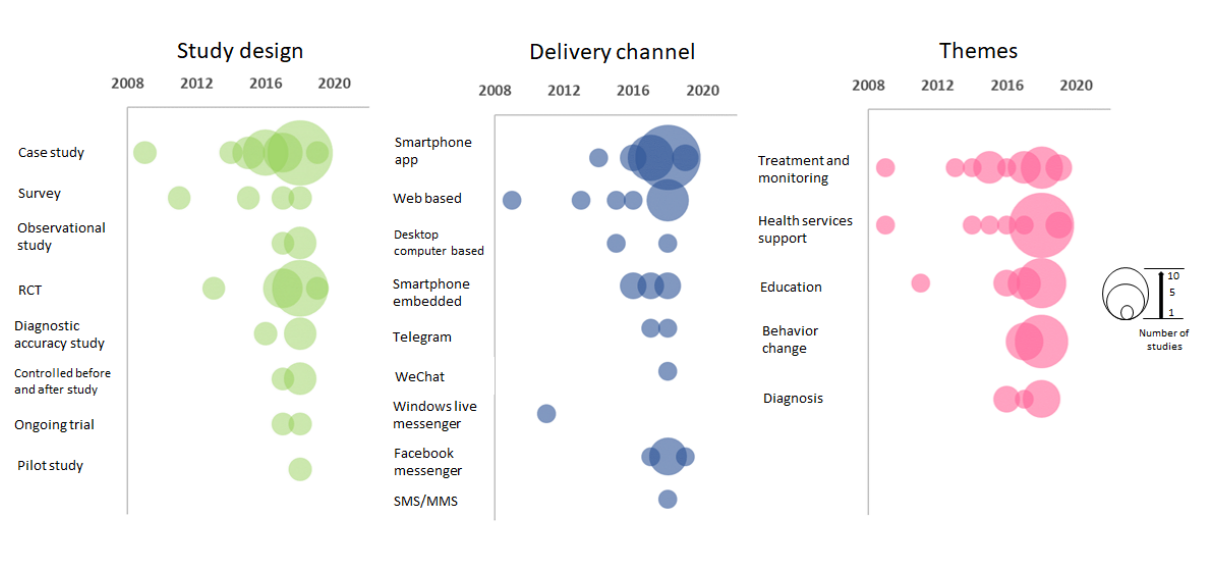
Figure 3. Bubble plots showing the distribution of identified study designs, types of conversational agents and healthcare topics in the included articles, plotted against the year of the publication. The scale on the right indicates that the size of the bubble is associated with the number of studies whereby the smallest denotes 1 study and the largest, 10